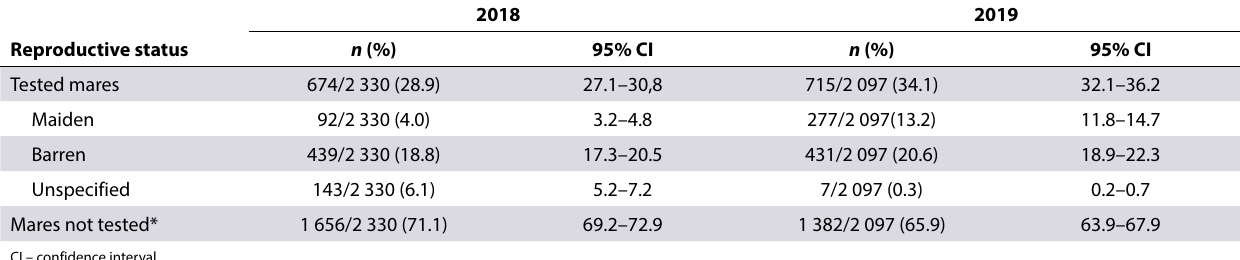
Table III: Summary of the proportion and percentage of Thoroughbred foals identified in 2020 ( n = 2 330) and 2021 ( n = 2 097) that originated from mares tested and not tested as part of the South African stud health scheme in 2018 and 2019 Reproductive status